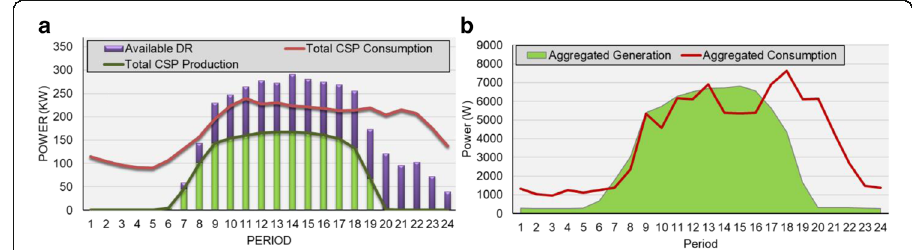
Fig. 6 Day-ahead consumption and generation profiles considered for case study: a Total CSP network, b Aggregated profiles from BUS #15, #10, and #5 by